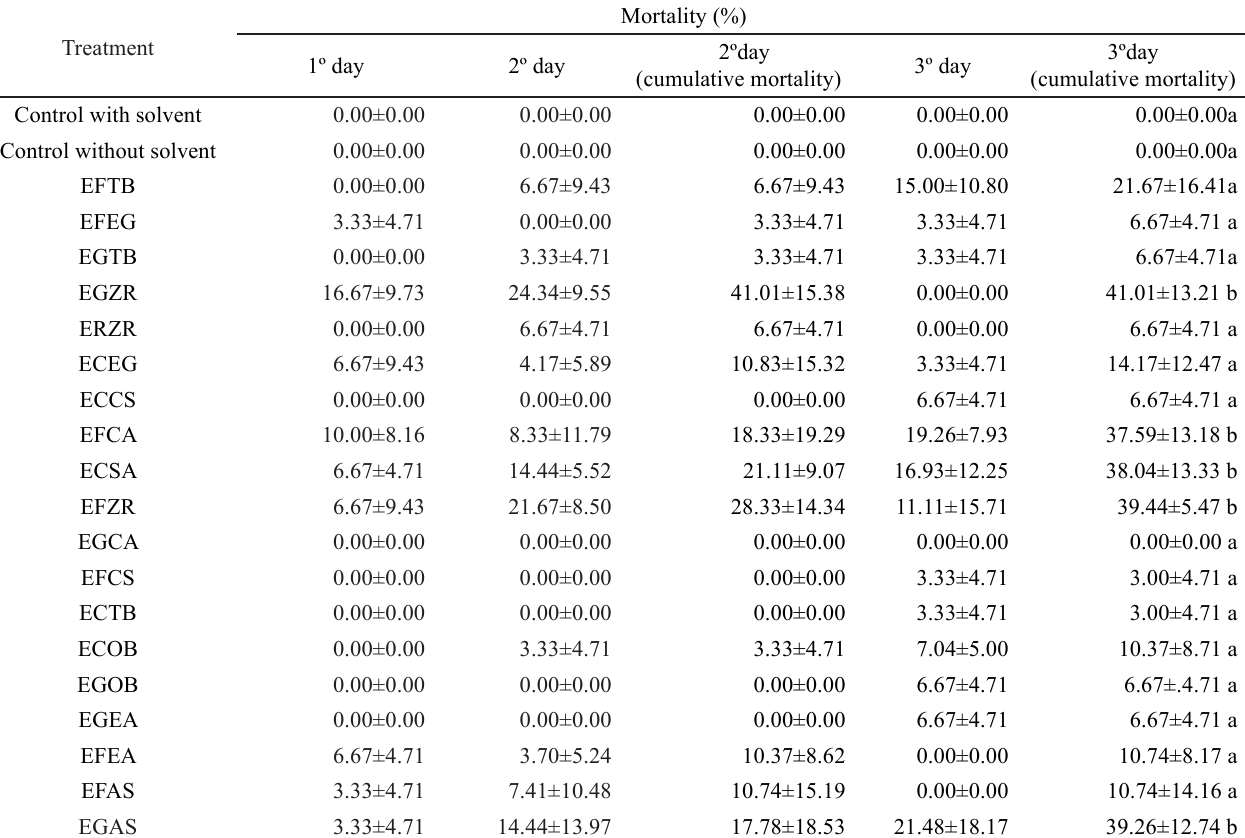
Table 2 . Mortality (%) of Atta sexdens sexdens (Hymenoptera: Formicidae) workers (mean and standard deviation) treated with plant extracts at concentration of 1 mg.mL -1 through topical